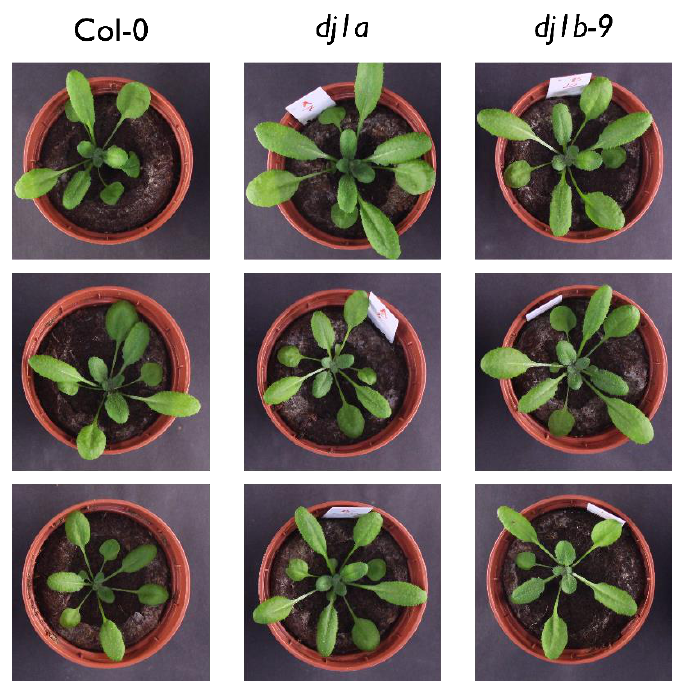
Figure 5. 3-week old plants lacking AtDJ-1A or AtDJ-1B are phenotypically identical to wildtype Col-0 plants. Col-0, dj1a and dj1b-9 plants were grown for 3 weeks in a long-day light regimen (16 h/8 h light/dark, 21 °C for 3 weeks. Representative bright-light images were taken 21 days after sowing.